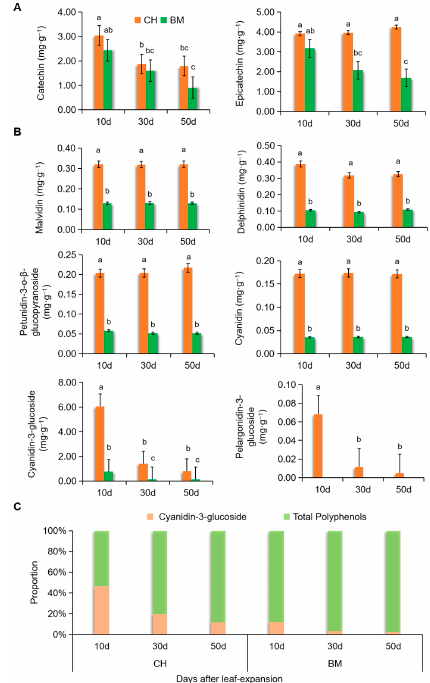
Figure 3. Contents of polyphenols including catechin and epicatechin ( A ) and anthocyanins including Figure 3. （ replaced ） Contents of polyphenols including catechin and epicatechin ( A ) and anthocyanins including malvidin, delphinidin, petunidin-3-o- β -glucoside, cyanidin, cyanidin-3- malvidin, delphinidin, petunidin-3-o- β -glucoside, cyanidin, cyanidin-3-glucoside, and pelargonidin-3- glucoside, and pelargonidin-3-glucoside ( B ) measured by UPLC-MS/MS. ( C ) Proportion of total polyphenols and cyanidin-3-glucoside in CH and BM leaves at different growth stages. Data are glucoside ( B ) measured by UPLC-MS / MS. ( C ) Proportion of total polyphenols and cyanidin-3-glucoside means ± standard deviation (SD), n = 3. Different letters above the bars indicate significant differences in CH and BM leaves at di ff erent growth stages. Data are means ± standard deviation (SD), n = 3. ( p < 0.05, one-way ANOVA). Di ff erent letters above the bars indicate significant di ff erences ( p < 0.05, one-way The anthocyanins affecting yellow and blue color in leaves, such as malvidin, delphinidin and petunidin-3-o- β -glucoside, showed stable contents across growth stages, which was consistent with the leaf color phenotype and the a* value (Figure 1). The age-dependent reduction of cyanidin-3- glucoside, the main elicitor of red color in CH young leaves, was also the main reason of decrease of anthocyanin proportion in pigments due to its large amount. Furthermore, the ratio between the contents of cyanidin-3-glucoside and the sum of catechin and epicatechin was obviously higher in CH than BM at each stage, and dropped quickly with age in CH (Figure 3C), which was in line with the leaf color changes from red to green and turning to dark.